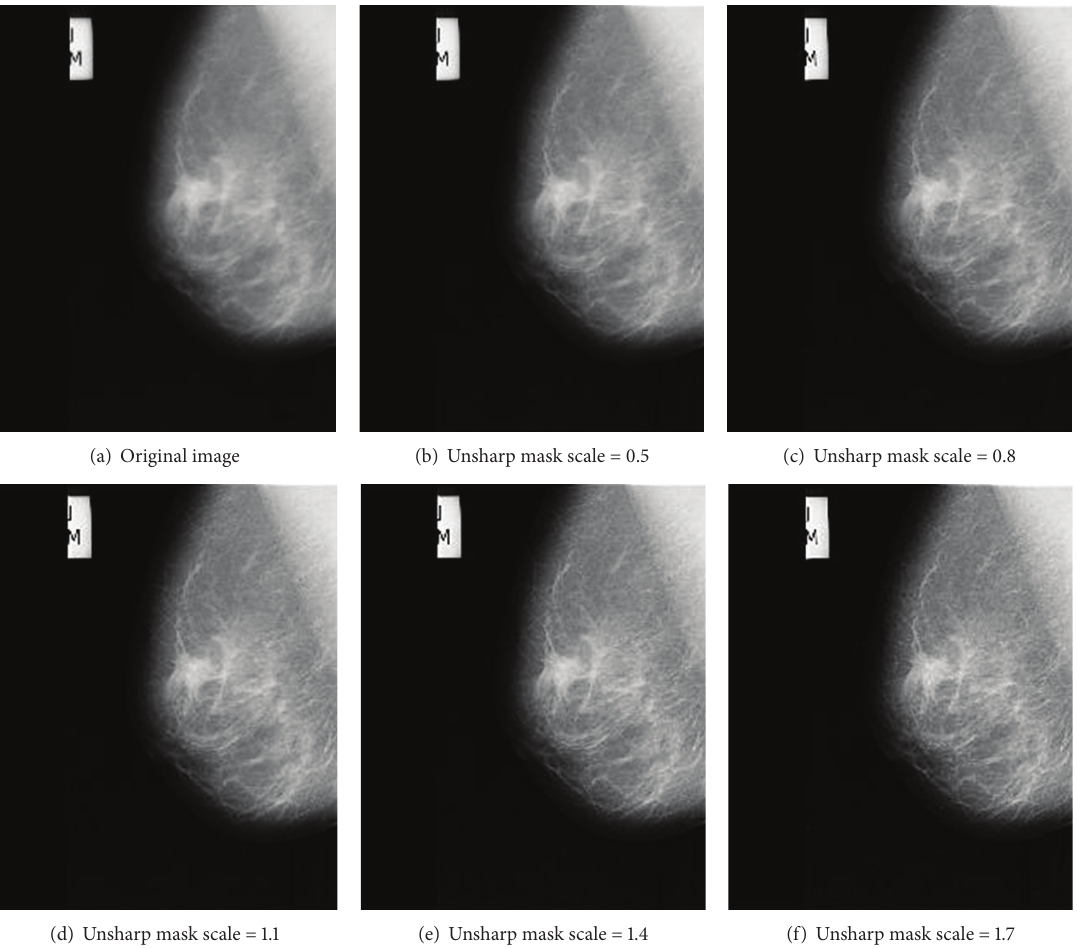
Figure 3: Image enhancement using unsharp masking. Higher unsharp mask scale results in higher contrast in enhanced